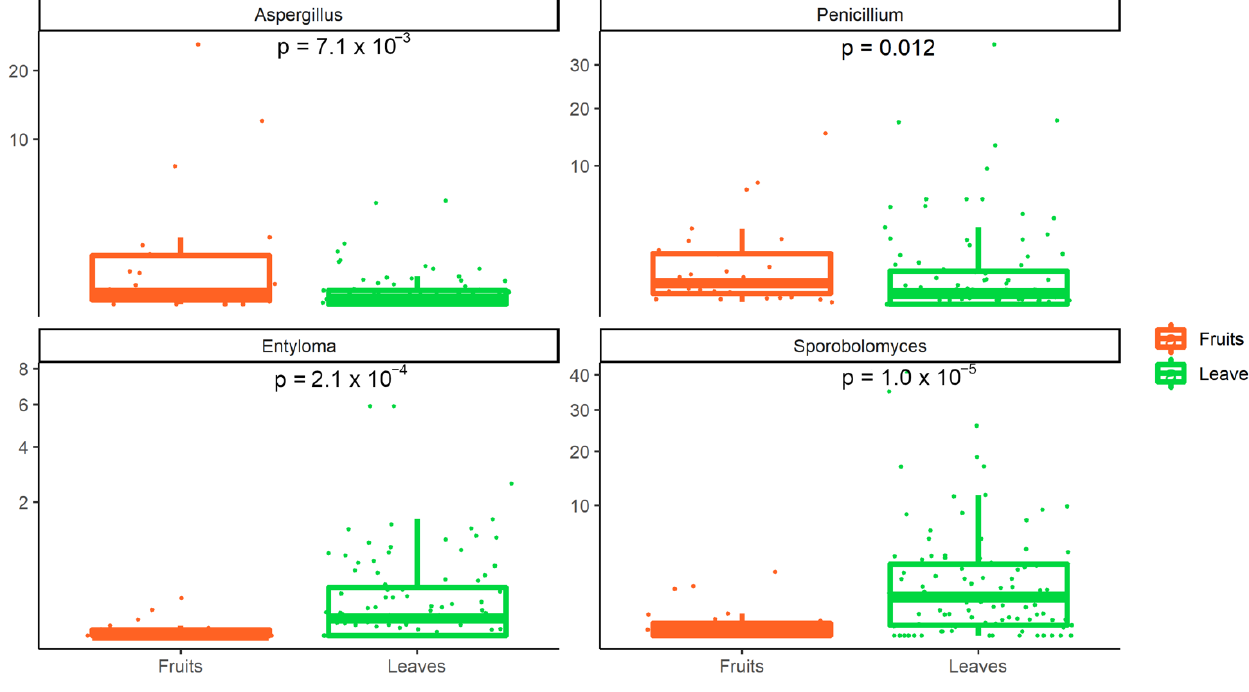
Figure 7. Fungal genera showing a significant difference between fruits and leaves.